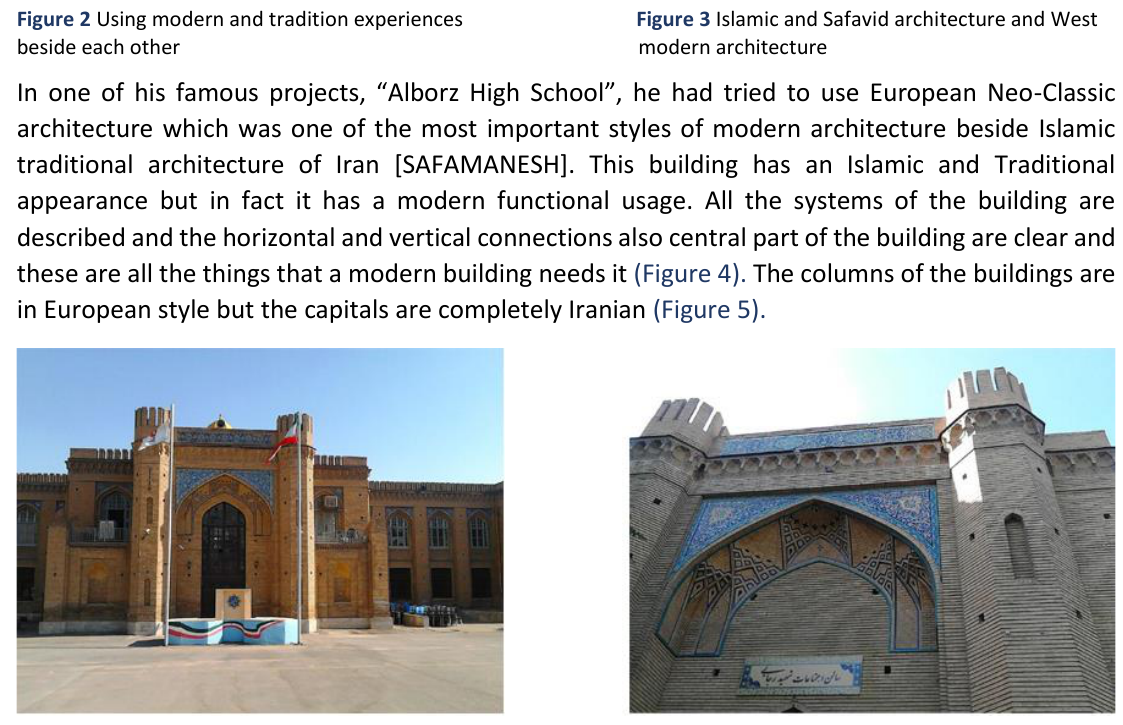
Figure 4 Islamic and traditional appearance Figure 5 Alborz High School, The West Neo-Classic and modern functions Architecture and Iranian Traditional